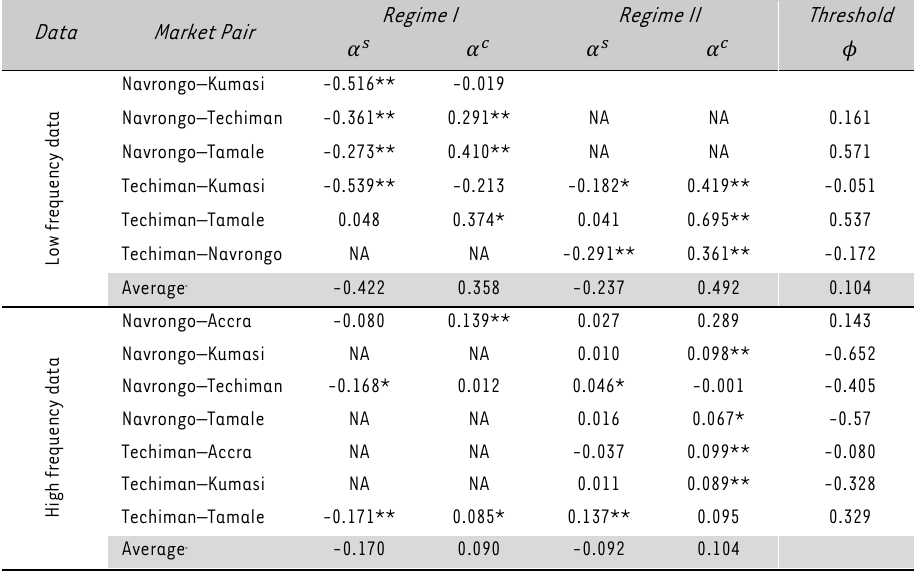
TABLE 4: Results of the threshold vector error correction model